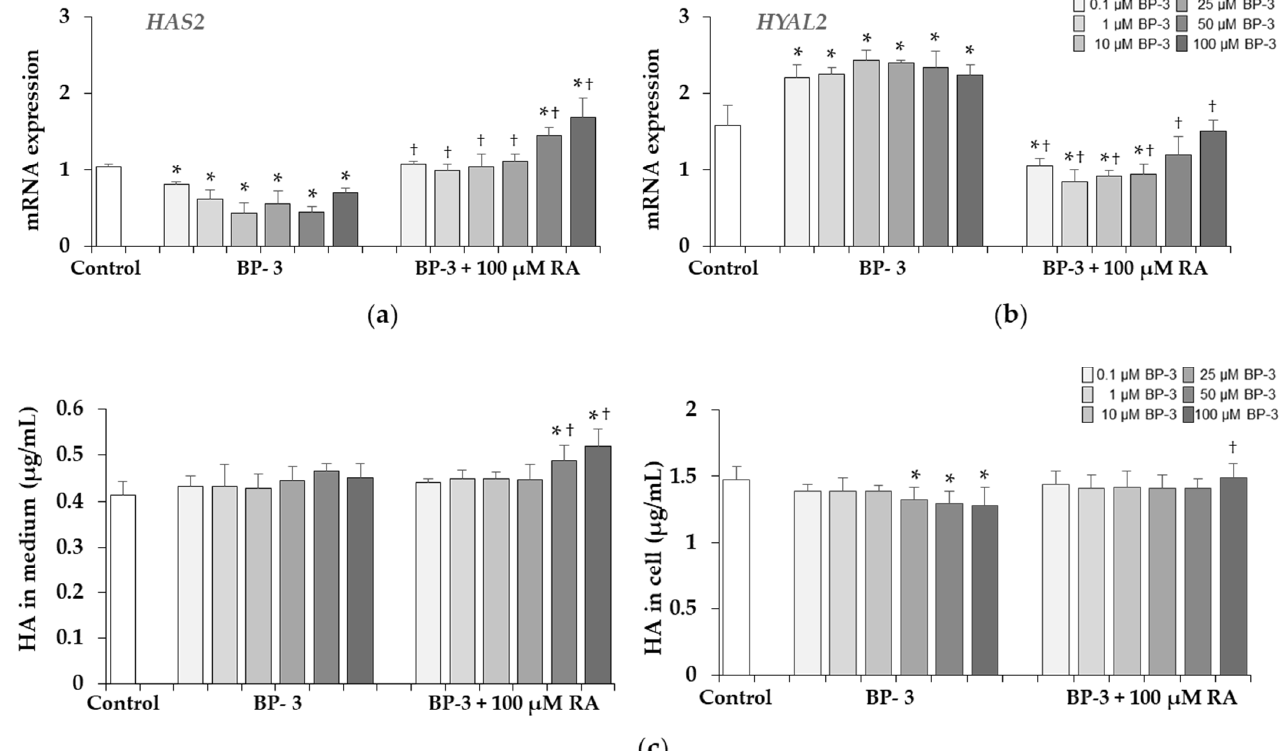
Figure 8. The influence of benzophenone-3 (BP-3) alone and in combination with rosmarinic acid (RA) on the expression of hyaluronan synthase 2 ( HAS2 ) ( a ) and hyaluronidase 2 ( HYAL2 ) ( b ) genes, and on the content of hyaluronic acid (HA) in the culture medium and cells ( c ), as determined by Hyaluronan Assay Purple-Jelley (Biocolor Ltd.). Values represent the mean ± SD of three experiments; * p < 0.05 vs. control (untreated cells); † p < 0.05 vs. respective samples treated with BP-3 alone.